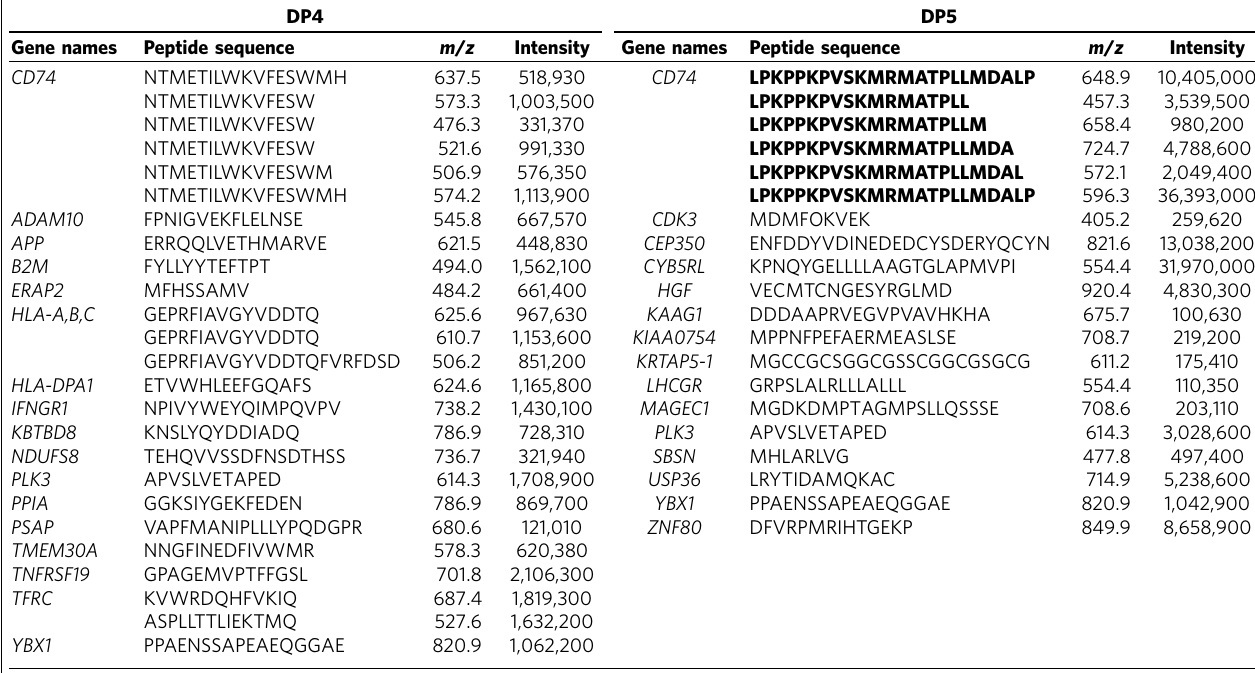
CLIP, class II-associated invariant chain peptide. Amino-acid sequences of peptides isolated from HLA-DP4 and DP5 molecules expressed in T2 transfectants through mass spectrometry are shown. The third column presents the m/z values of the peptides and the fourth column the intensity of the peptides observed in the liquid chromatography/mass spectrometry (LC/MS) mode. Identified CLIP sequences are indicated in